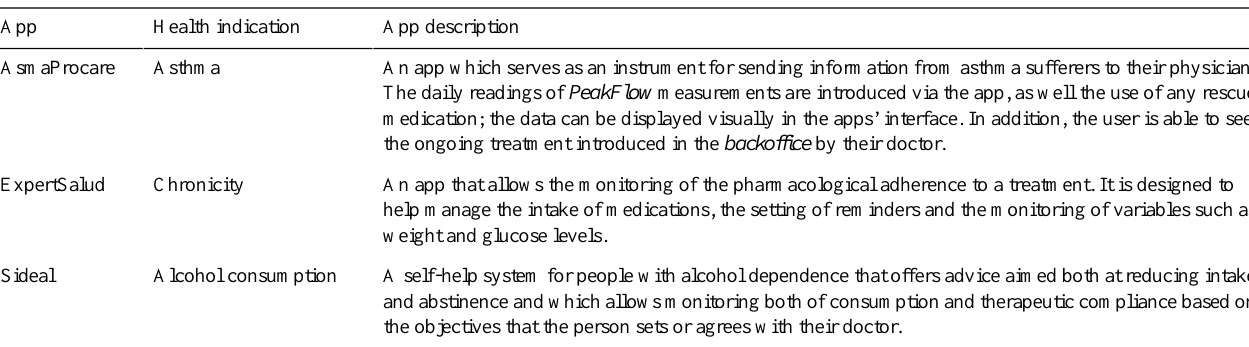
Table 2. Apps used in the pilot